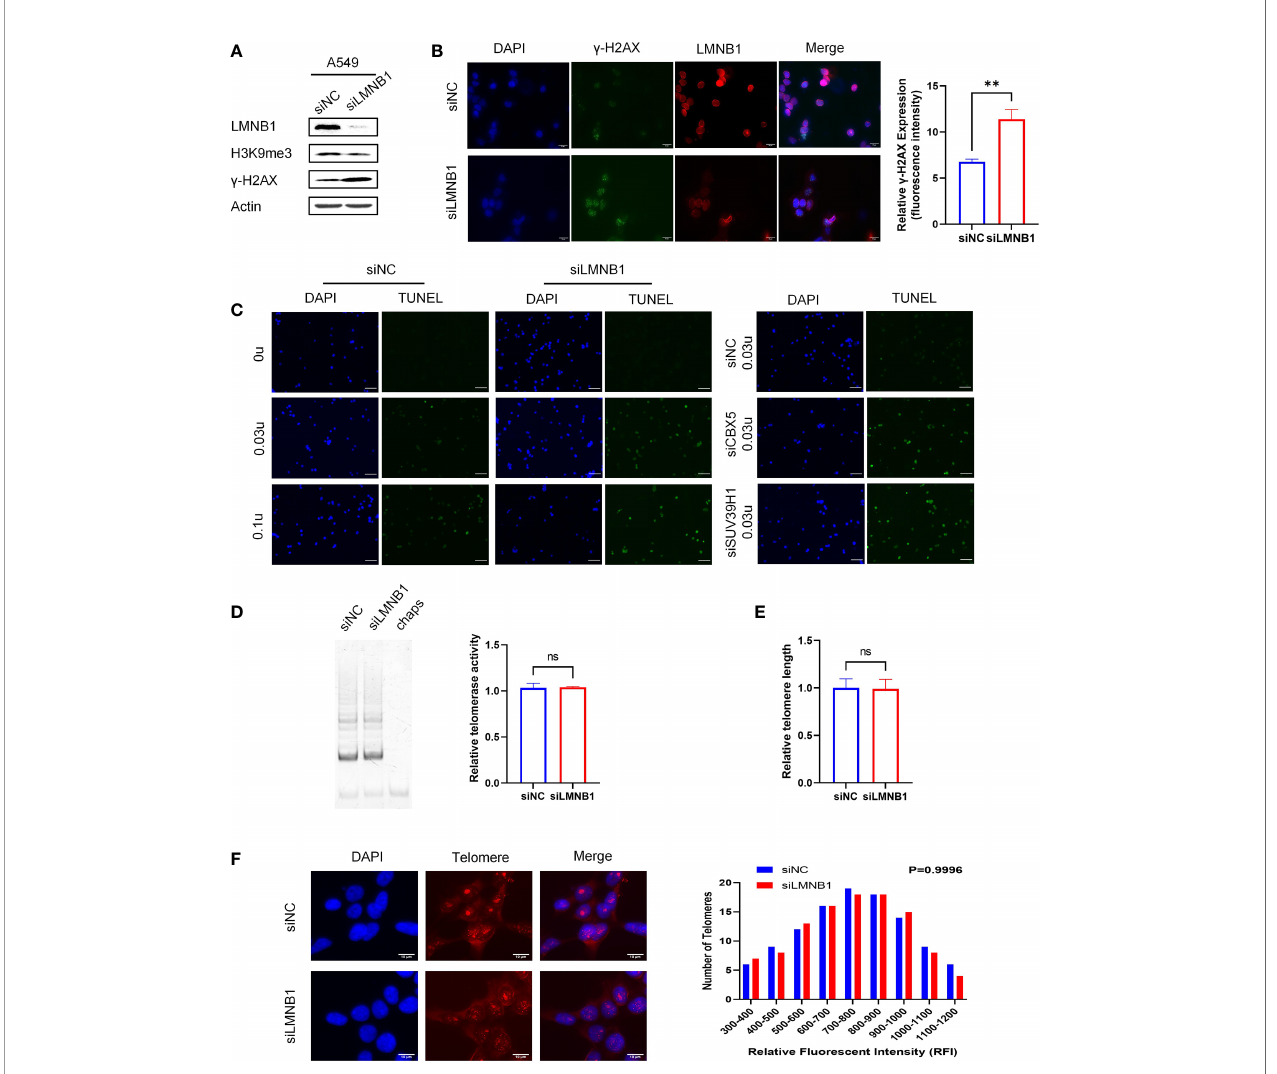
FIGURE 3 | The knockdown of LMNB1 increases chromosome accessibility by decreasing H3K9me3 protein expression. (A) A549 cells were transfected with LMNB1 siRNAs, and WB detected the expression of protein LMNB1, H3K9me3, g -H2AX, Actin. (B) Immuno fl uorescence was performed in A549 siLMNB1 cells to show g -H2AX (green fl uorescence) and LMNB1 (red fl uorescence) protein expression, Scale bar, 20 m m. (C) DNase I-TUNEL assay was performed (DNase concentration used 0 U, 0.03 U, 0.1 U) to detect the difference in chromosome accessibility between A549 siLMNB1 cells and A549 siNC cells. A549 cells of siCBX5 and siSUV39H1 were used as positive controls, Scale bar, 50 m m. (D) The telomerase activity of knockdown of LMNB1 and NC were detected by TRAP in A549 cells. (E) The telomere length of A549 siLMNB1 and siNC were detected by qPCR. (F) The telomere length of A549 siLMNB1 and siNC were detected by Telo- fi sh. **p<0.01, ns means no signi fi